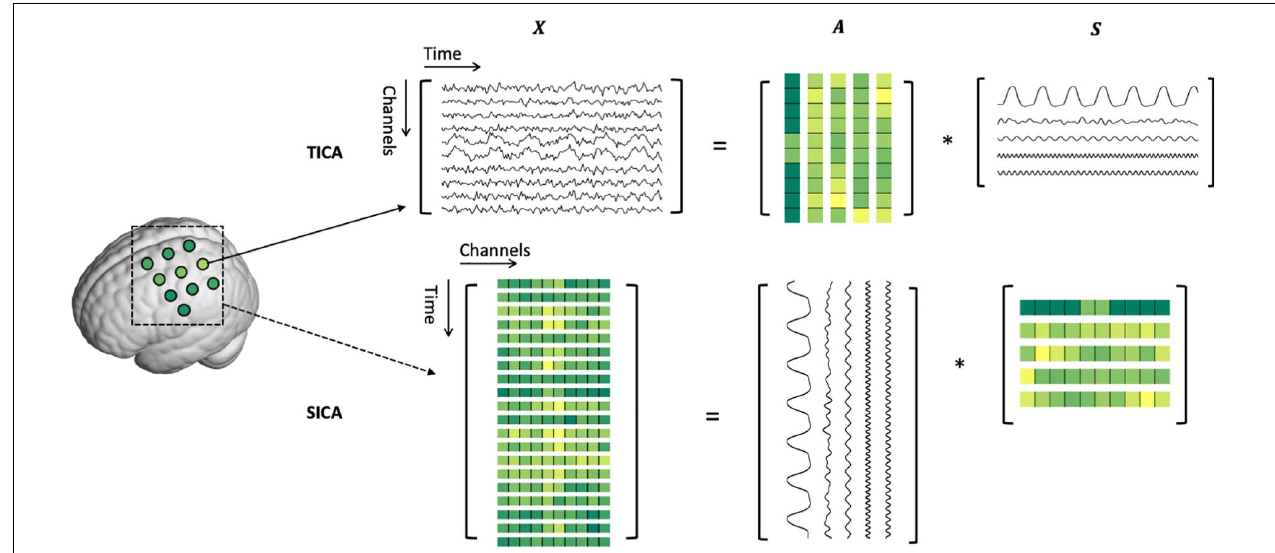
FIGURE 1 | Schematic depiction of temporal and spatial ICA for fNIRS